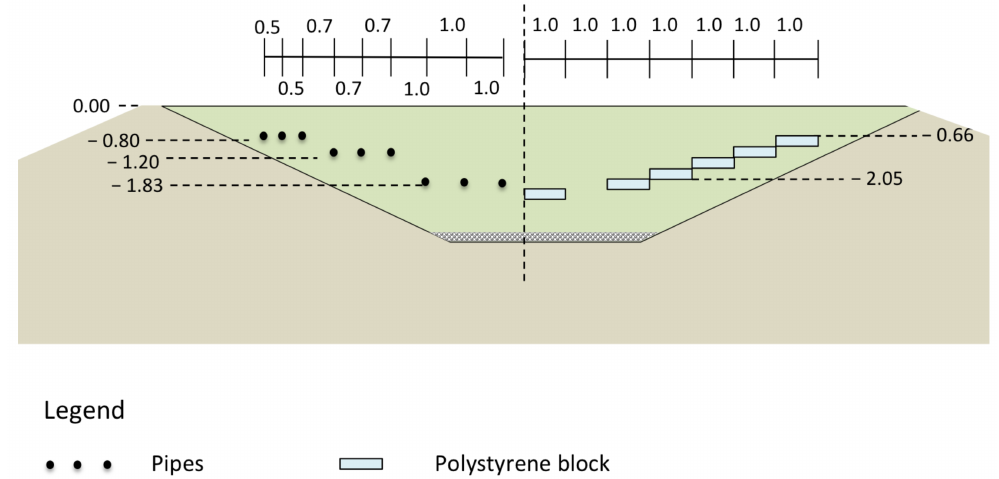
Figure 6. Transversal section of the silt region, showing the embedded targets and their positions. All distances are expressed in